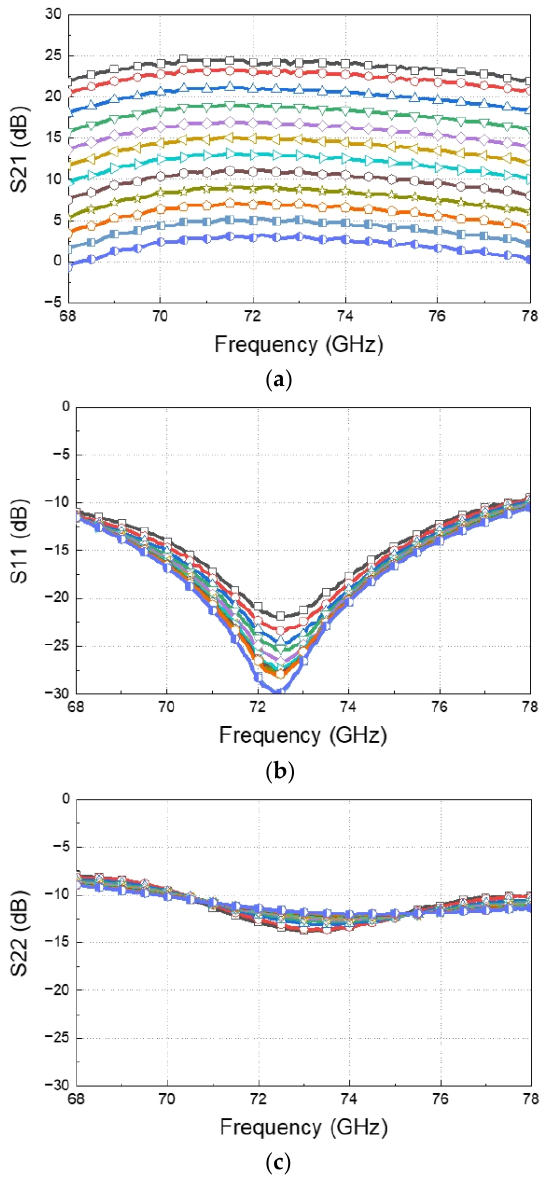
Figure 11. Measured ( a ) S 21 , ( b ) S 11, and ( c ) S 22 at various gate-bias voltages. The highest gain is when VG = 0.55 V, and the lowest gain is when VG = 0.225 V.